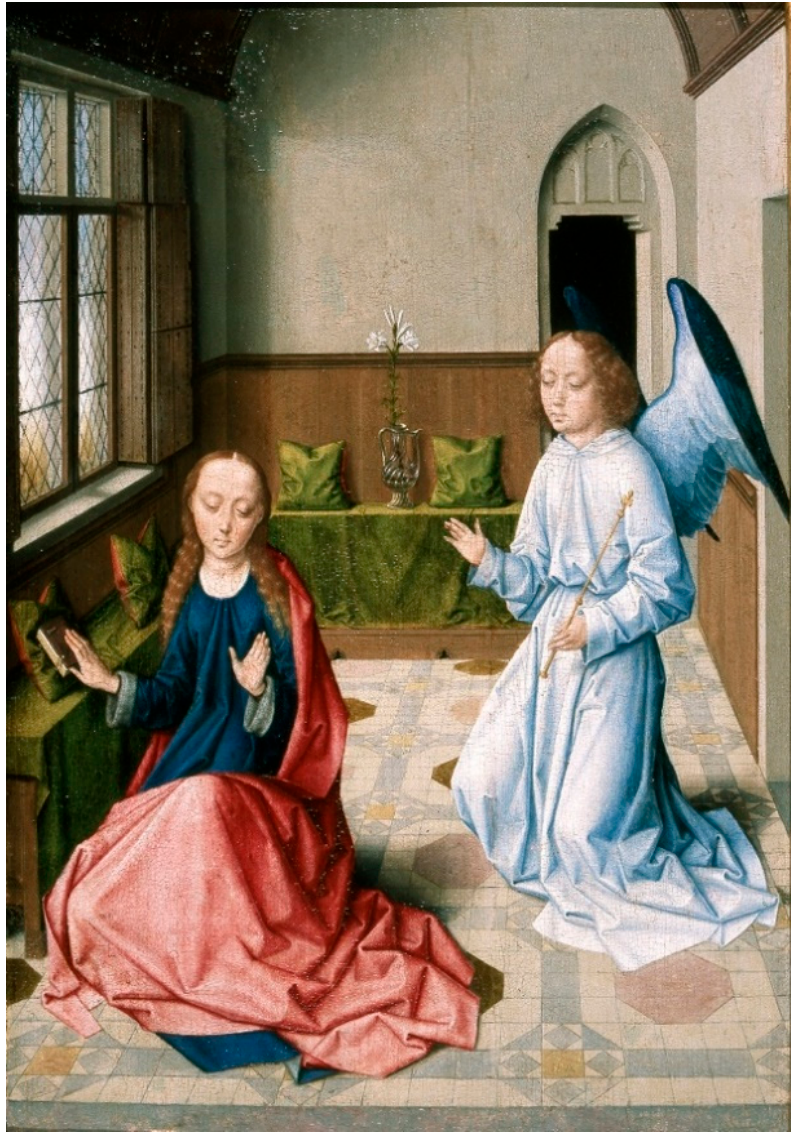
Figure 12. Dirk Bouts, The Annunciation , c. 1475–1487. The Muzeum Czartoryskich,